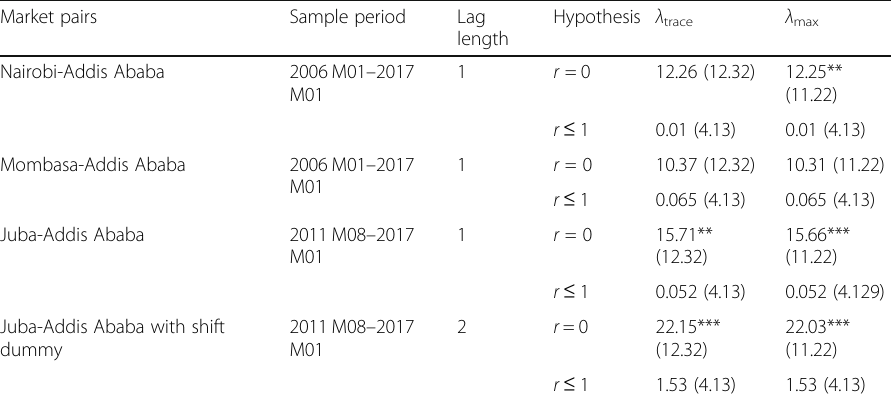
Hypothesis λ trace λ max length